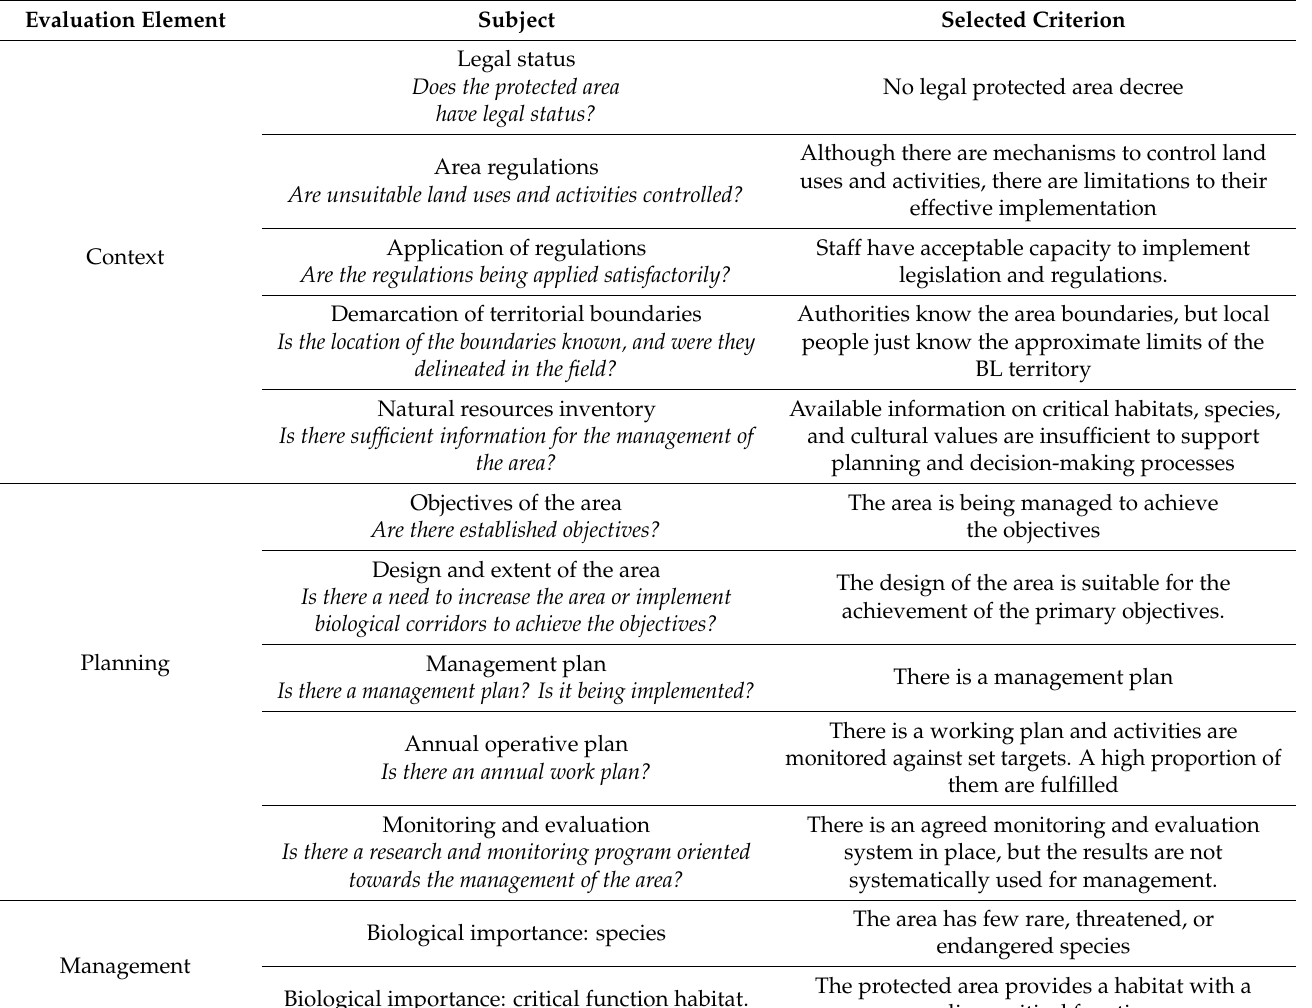
Table 2. Assessment of the characteristics and design of the protected area (based on WCPA and WWF